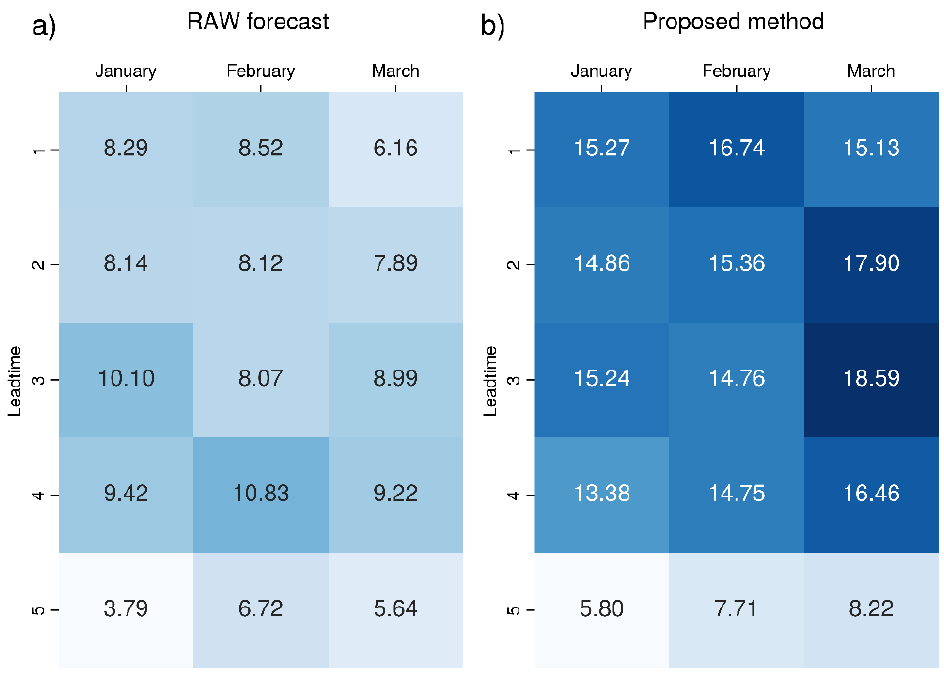
Figure 12. Mean percentage of ensemble members correctly predicting 2 m mean temperature over the 99th percentile value for seasonal forecast System 7 (Météo-France): ( a ) raw data and ( b ) data corrected with the proposed bias correction method. The colour scale ranges from white (0%) to dark blue, increasing in intensity as the percentage increases. The most intense colour corre- sponds to the maximum value.